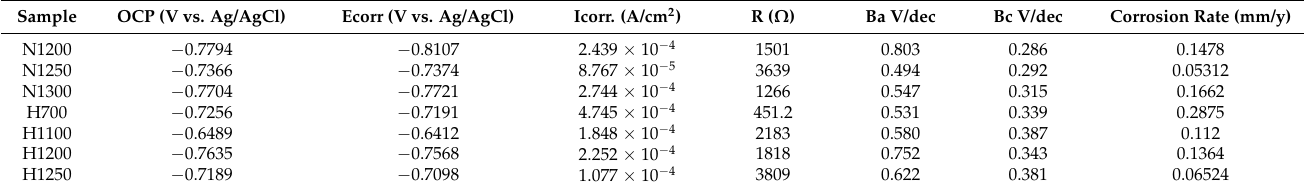
Table 8. Corrosion parameters of the as-fabricated porous HNASS samples obtained from the potentiodynamic polarization curves.